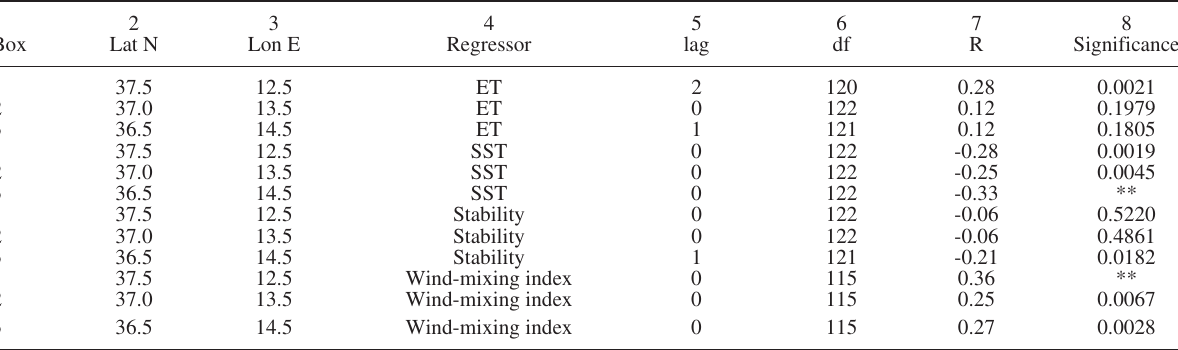
Fig . 9. – Climatological mean Chl a vs offshore Ekman transport (a), phosphate concentration at the depth layer 75-200 m (b), nitrate concen- tration at depth layer 75-200 m (c), and silicate concentration at the depth layer 75-200 m (d) for the selected Mediterranean Table 2. – Statistical results of linear regression models relating Chl a (regressand) and Ekman transport (ET), SST, stability, and wind- mixing index (regressors). For each geographical 1° × 1° box of Figure 1—identified in the columns 1, 2, and 3 (coordinates refer to the centre of 1° × 1° cells)—four linear models were fitted by regression between trend-removed monthly time series, one for each available regressor. For each model, Pearson’s correlation coefficients (R) between regressors and regressand (Chl a ) reported in column 7 represent the maximum absolute values obtained among tested regressions at lags 0, 1, and 2 (column 5), with degrees of freedom given in column 6. Column 8 indicates the significance of the observed correlation on the basis of Bonferroni correction (“*” p<0.05/36; “**” p<0.01/36; “***” p<0.001/36). The critical p-value at the 0.05 significance level, with Bonferroni correction, is 0.001389.